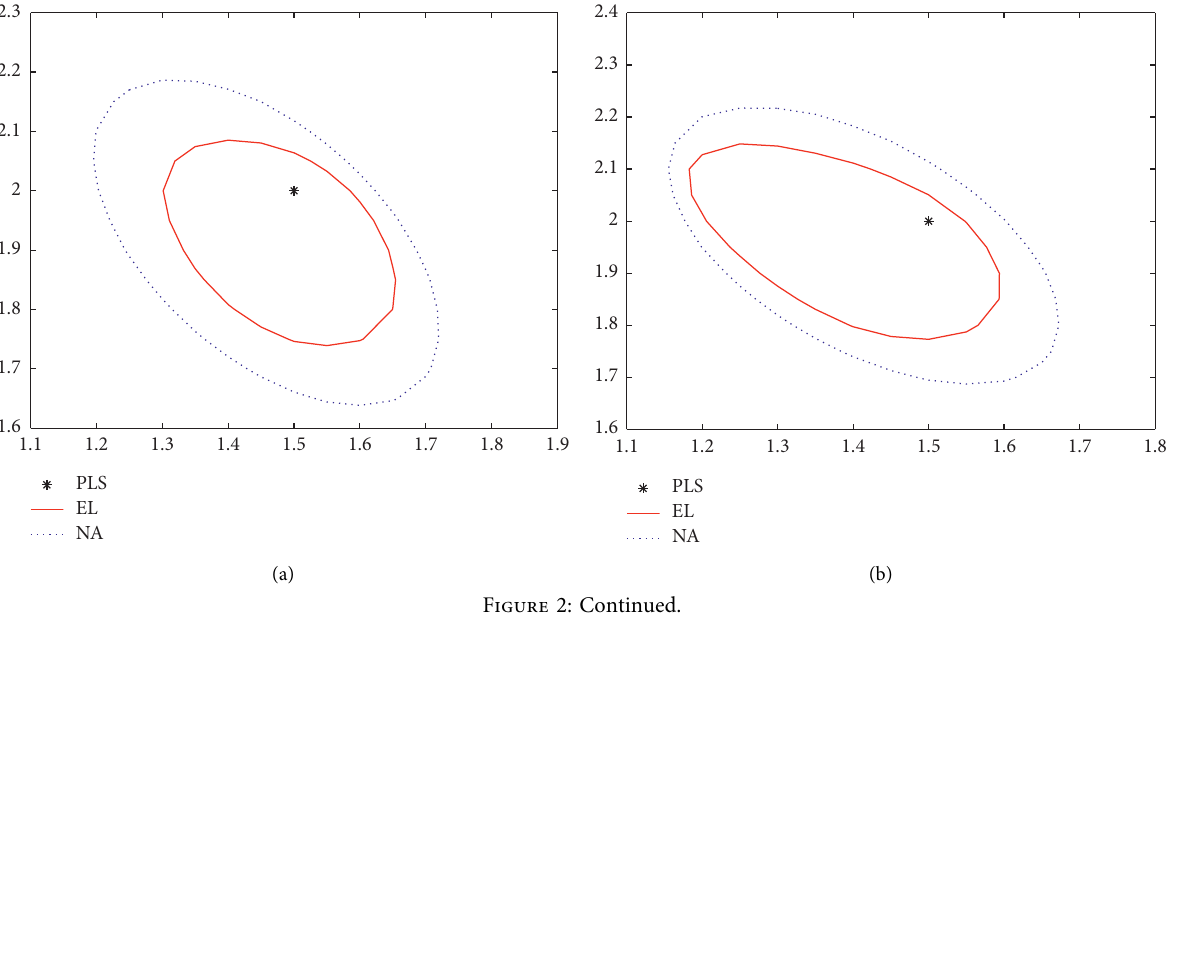
, β ) with CR � 10% (a), CR � 20% (b), and CR � 30% (c) based on ϵ ∼ N ( 0 , 1 ) 1 2